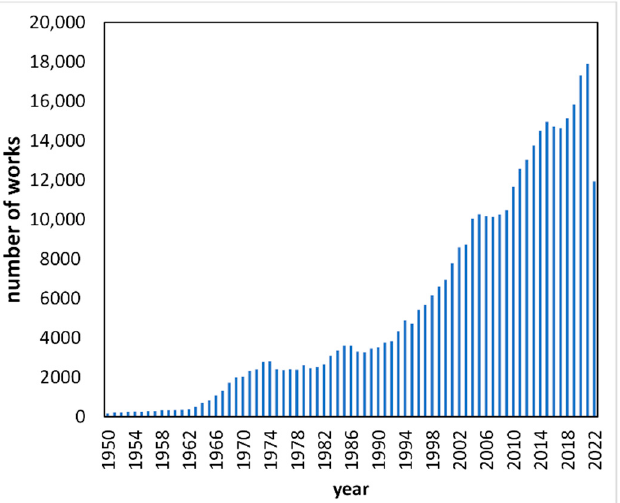
Figure 1. Number of scientific works where the “solubility” term appeared in abstract, title or keywords in 1950–2022 (Scopus, august 2022).